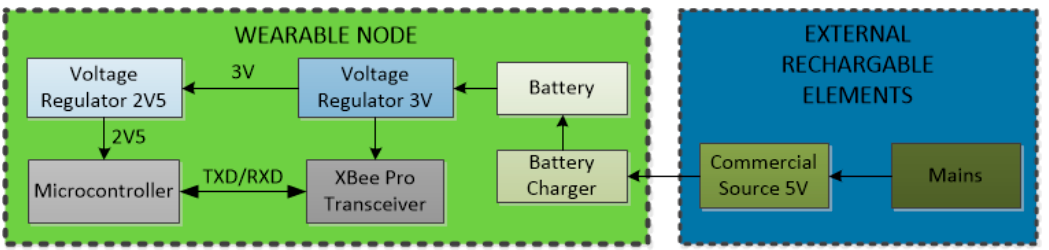
Figure 1. Wearable sensor node block diagram.